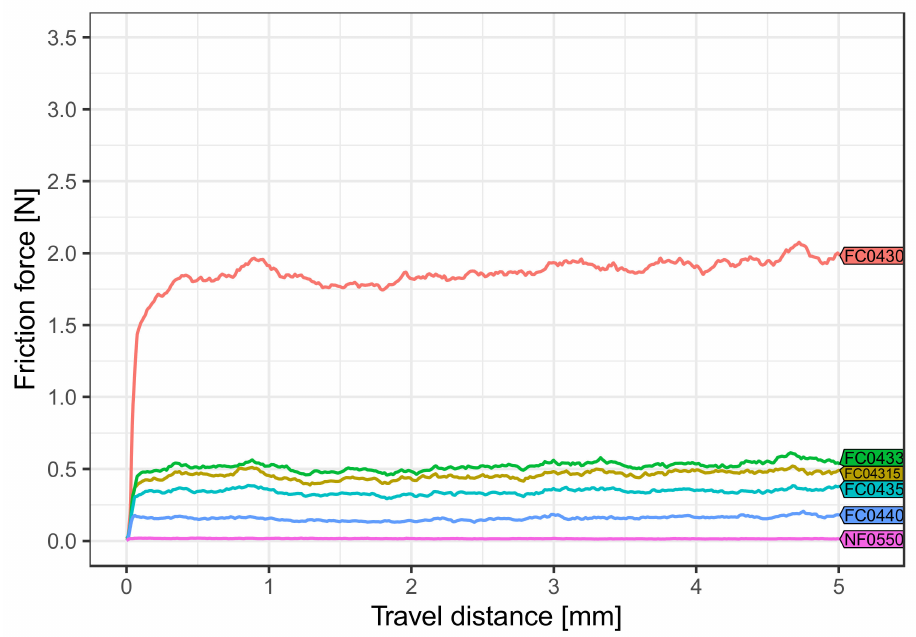
Figure 4. Effect of body temperature (36 ± 1 ◦ C) and dry storage. The average intensity of friction force was reduced for the V-shaped archwire and V-slot in combination with the different coverings. Coverings able to generate frictional forces showed higher values (2.0 N) than those without this ability (0.1